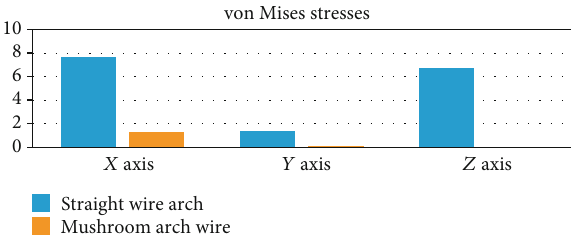
Figure 27: von Mises stresses (MPa). The graph shows a comparison between von Mises stresses that were generated in each of the analyzed sections: complete system (mandibular bone, dental organs, brackets, and wires) and separately the mandible and the two di ff erent types of arches or